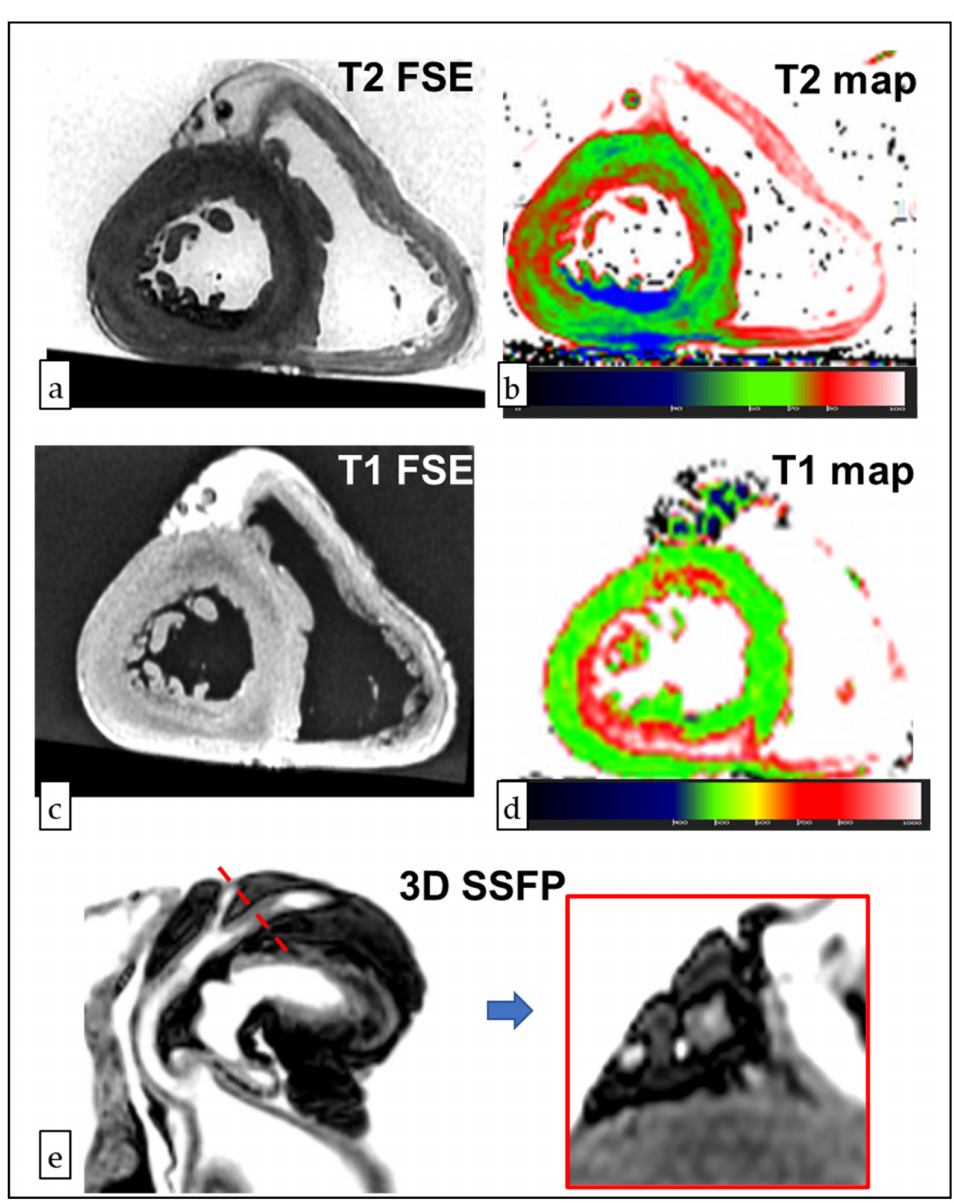
Figure 2. Post-mortem Cardiac Magnetic Resonance (PM-CMR) and immunohistochemical stain- ing of case #4. In the panel ( a ), a T2-weighted fast spin echo (FSE) image shows the hypointensity of the subendocardial layer of the inferior and inferolateral walls. A decreased T2 was confirmed in the T2 mapping (panel b ), whereas T1 hyperintensity and an increased T1 were found in the border zone (T1 FSE of panel c , T1 mapping in panel d ). The reconstruction of 3D-SSFP images showed a >90% obstruction of the left circumflex artery (panel e